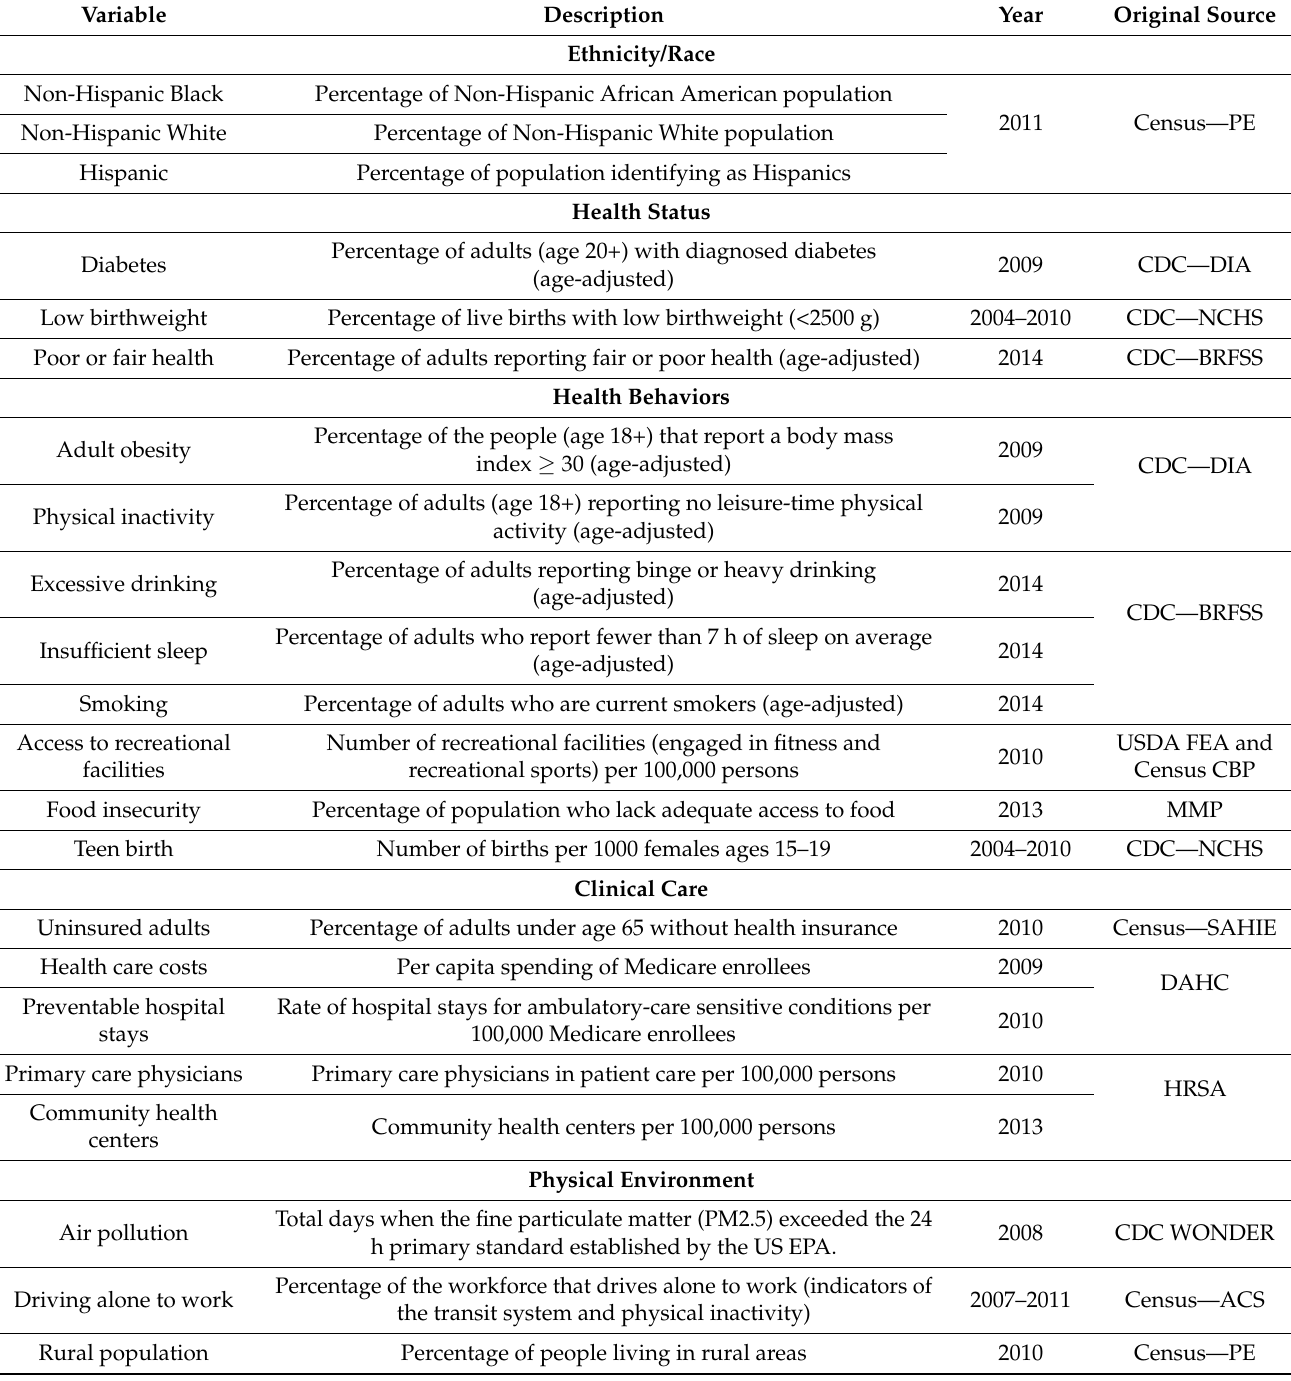
Table 1. County-level explanatory variables used in random forest